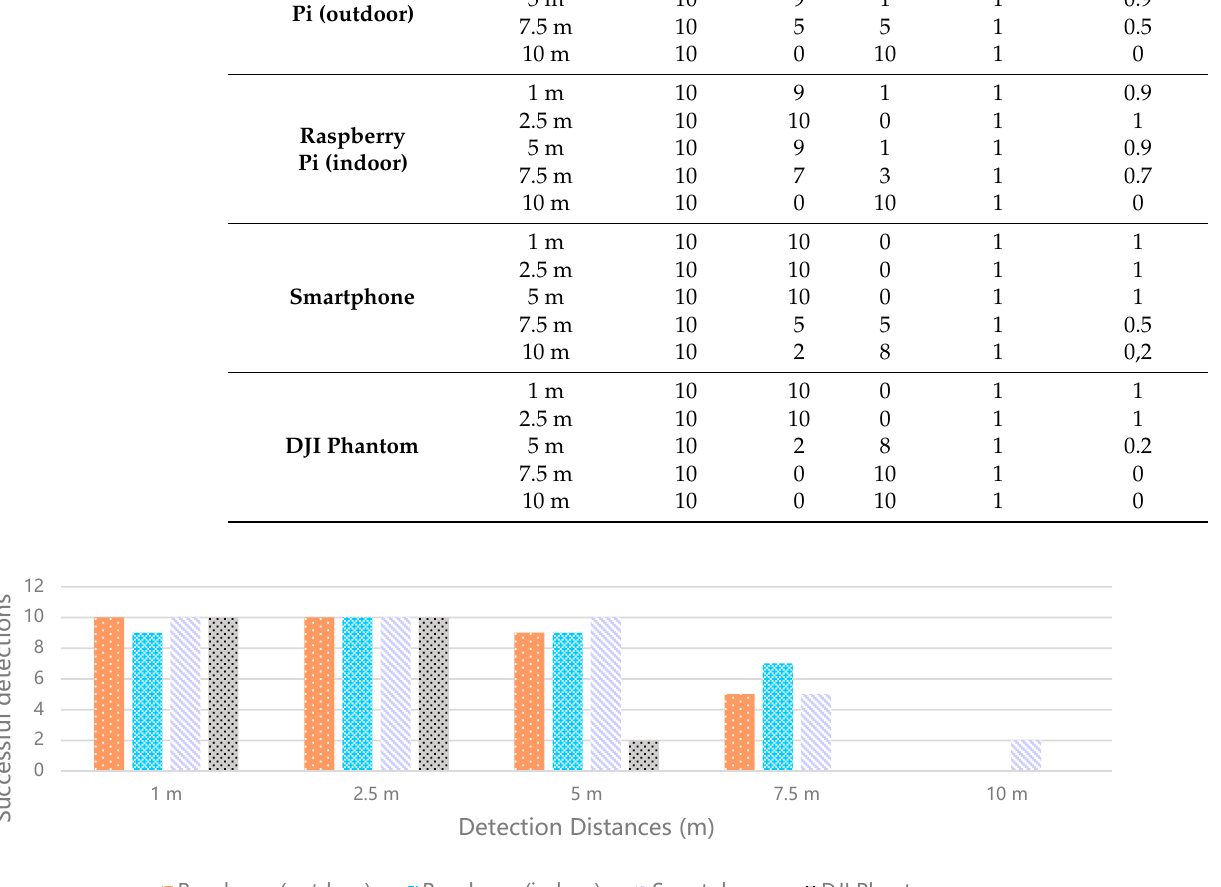
Table 5. Compilation of the results from Test 1, categorized by test scenario and distance. Iteration